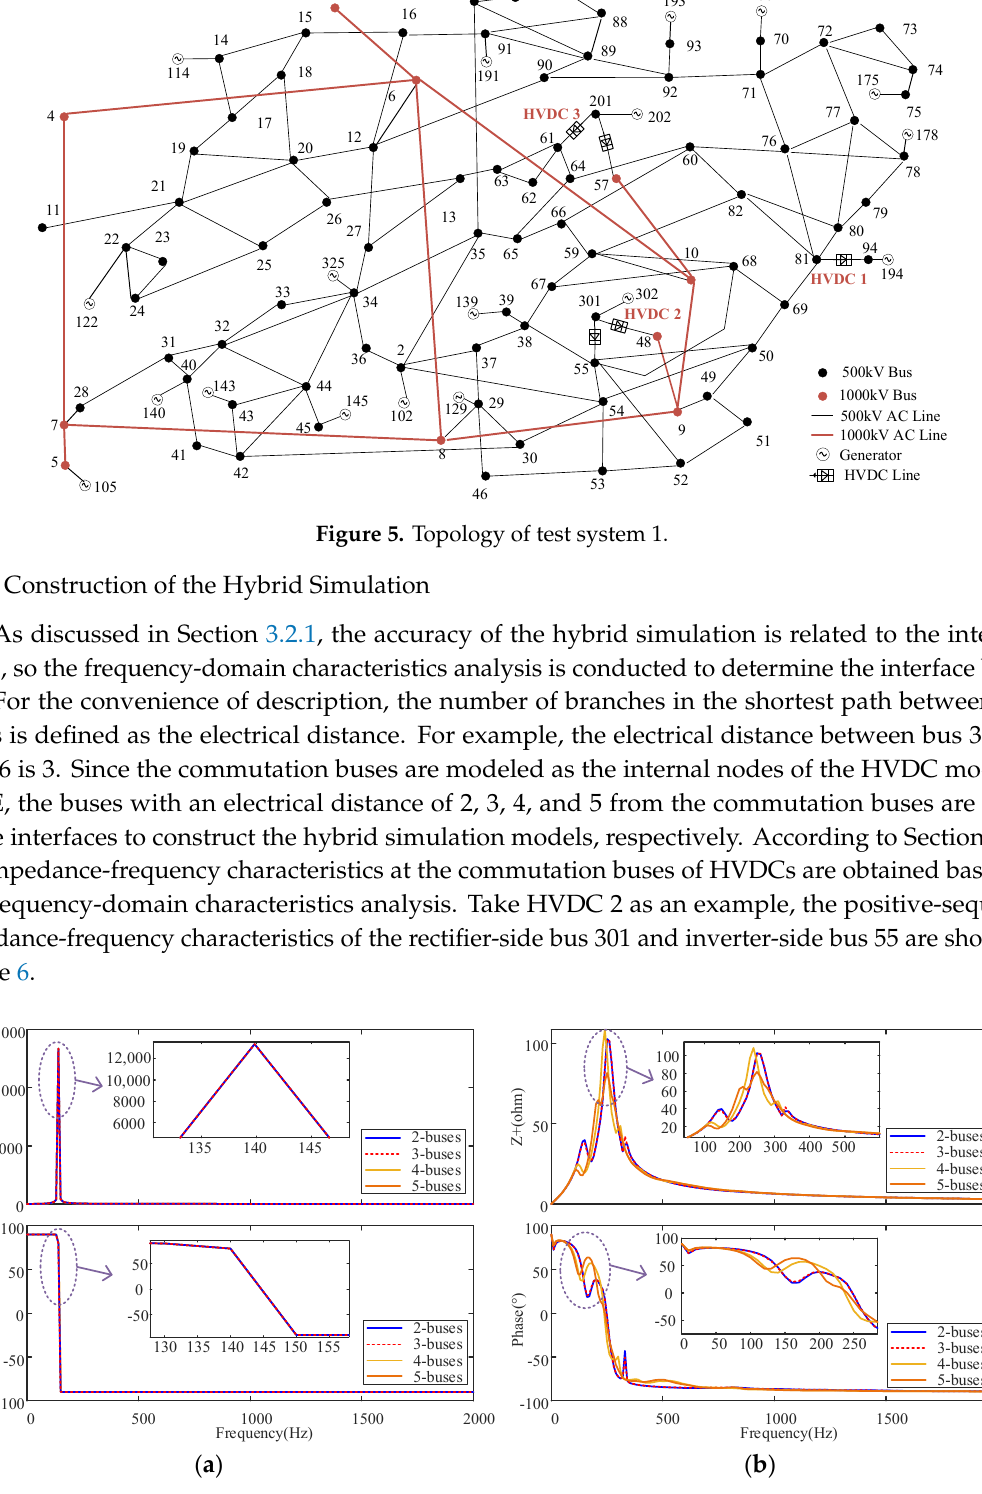
Figure 5. Topology of test system 1.